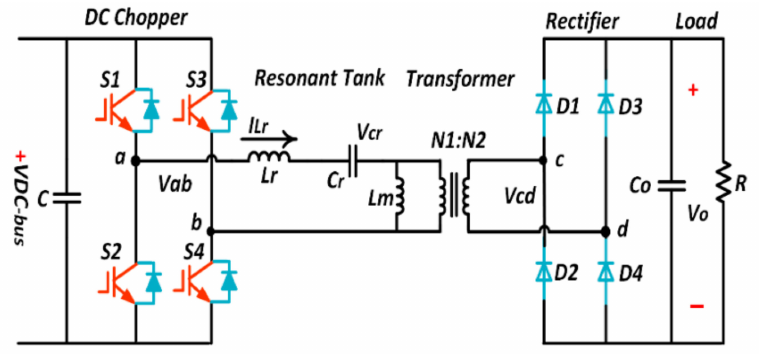
Figure 34. Circuit diagram of full-bridge LLC resonant converter